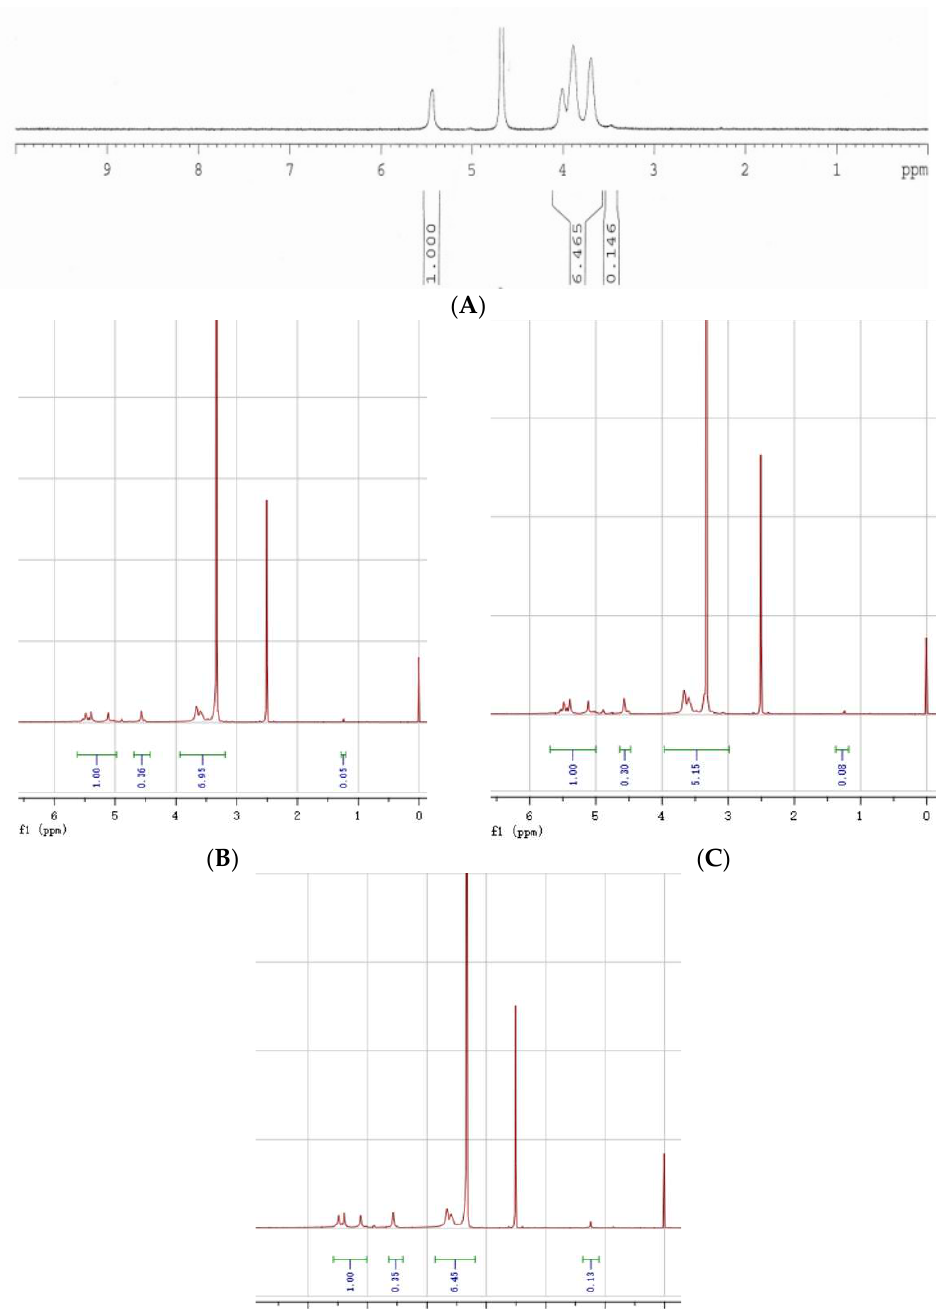
Figure 7. H-NMR spectra of δ-HBS at ( D ) MS = 0.12, ( C ) MS = 0.076, ( B ) MS = 0.042, and ( A ) unmodified starch.